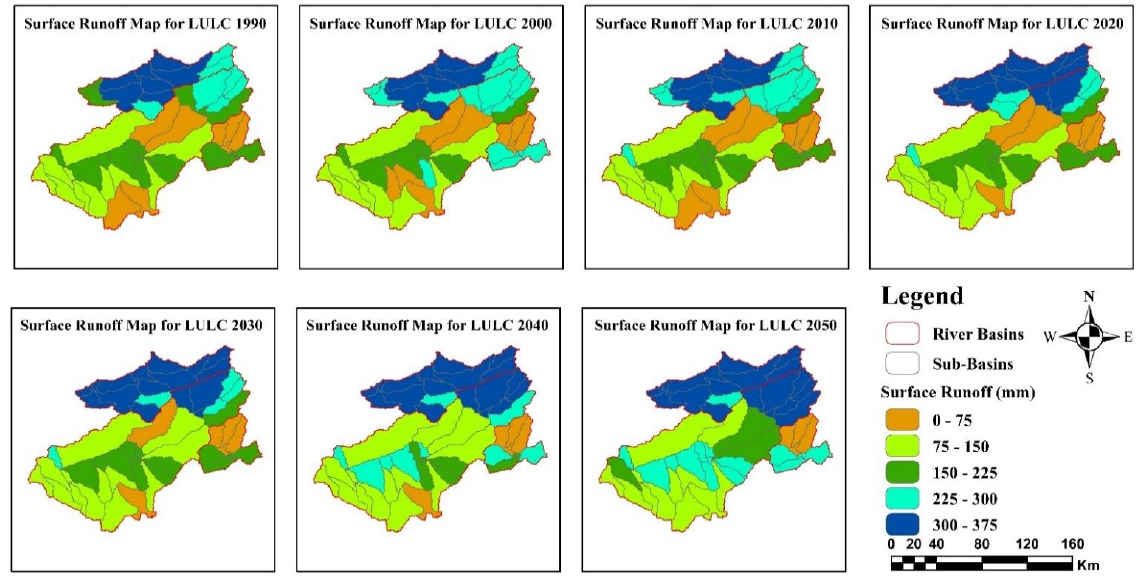
Figure 6. Spatial and temporal distribution of variations in simulated surface runoff.